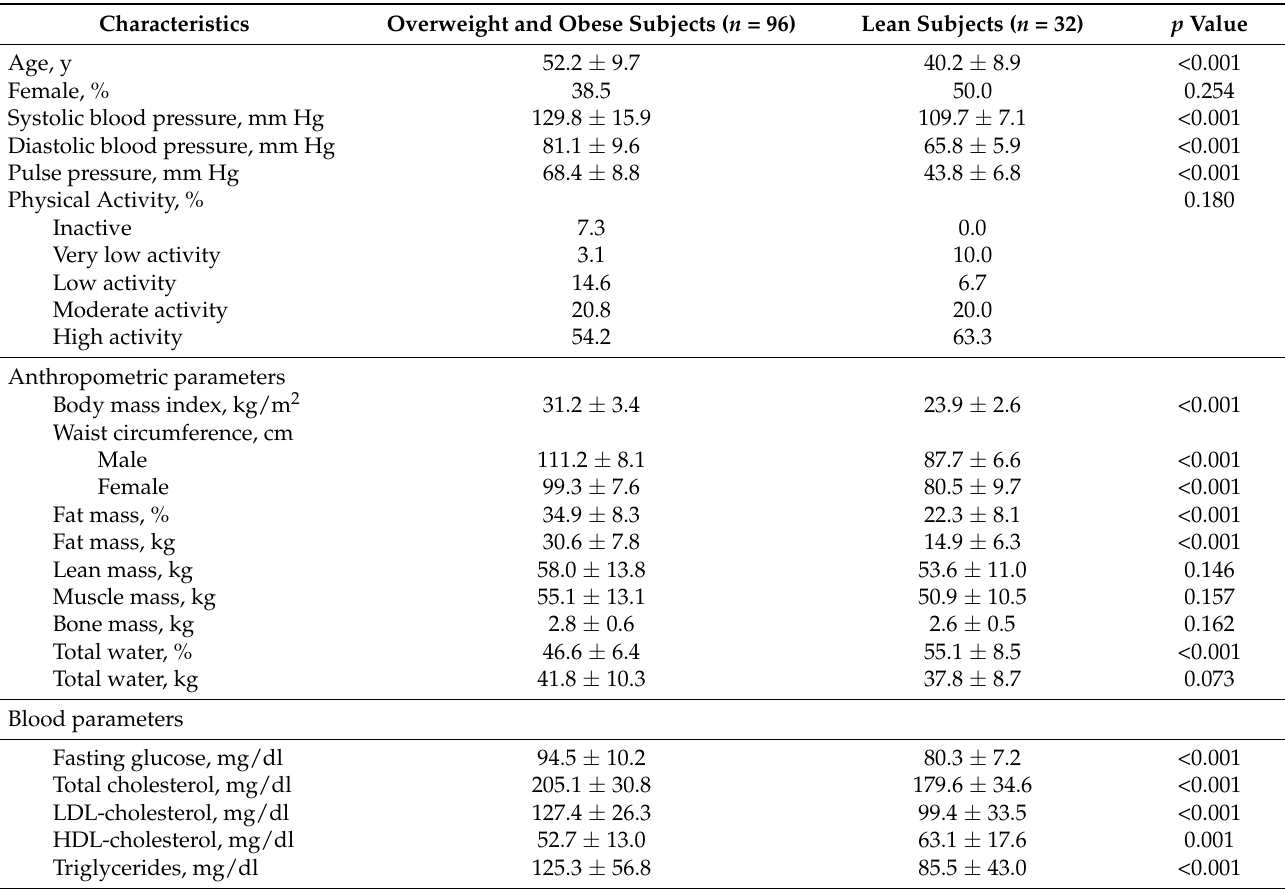
Table 1. General characteristics of overweight/obese and lean subjects included in the cross-sectional